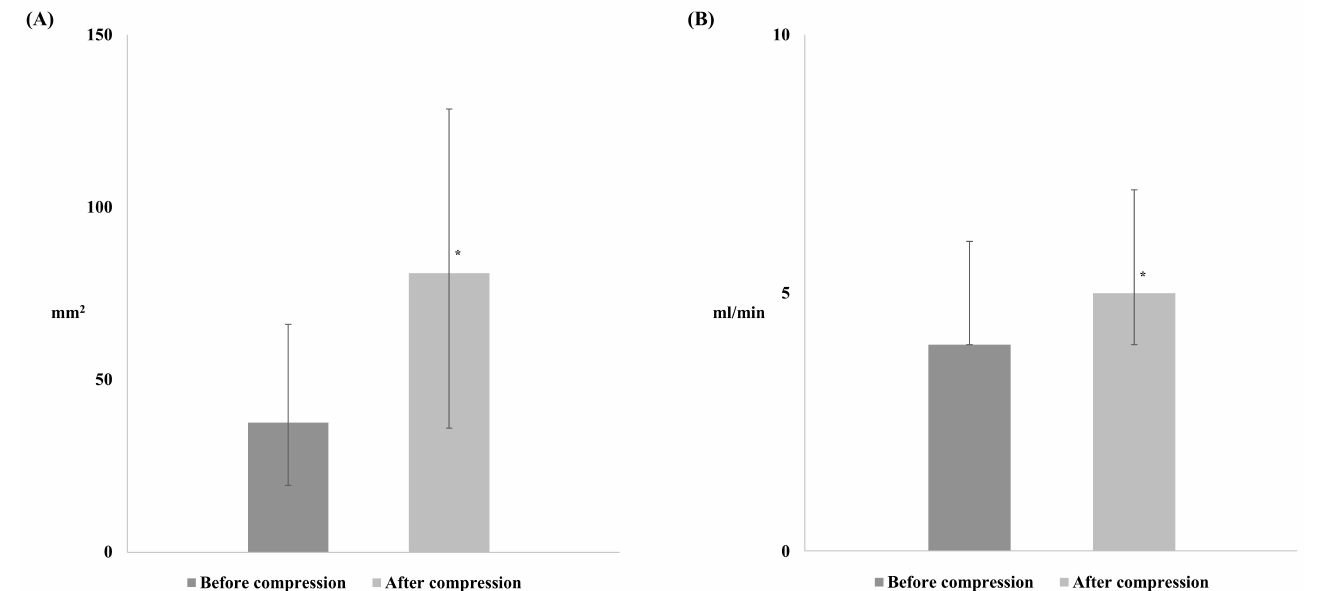
Figure 1. The changes in the blood flow (BF) and the internal cross-sectional area of the radial artery before and after the compression of the ulnar artery in Compression group. ( A ) BF, ( B ) CSAi. * p < 0.05 compared with before compression.